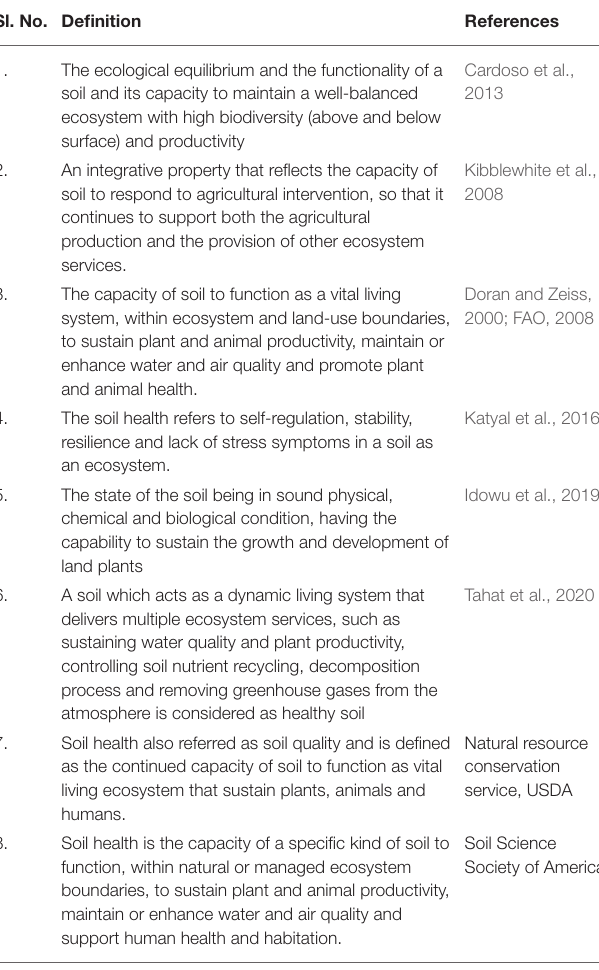
TABLE 1 | Definitions of soil health given by different